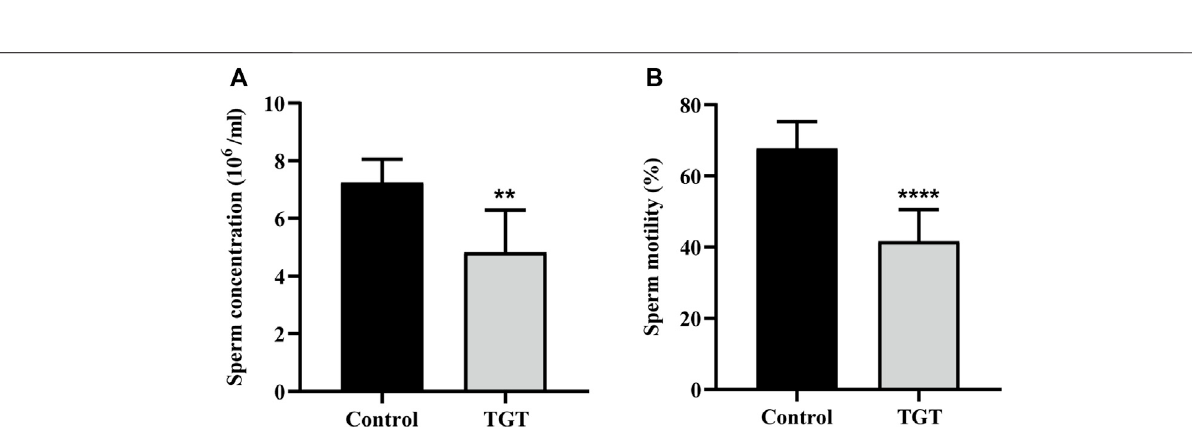
Frontiers in Pharmacology |